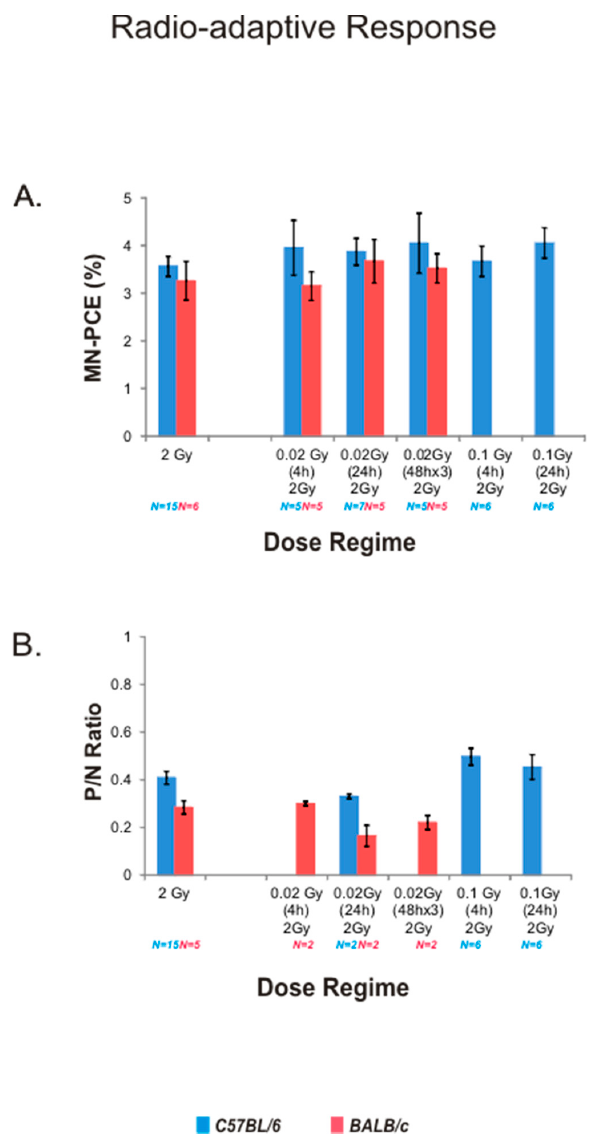
Figure 4. Radio-adaptive response analysis of MN-PCE frequencies and P / N Ratios in mouse bone marrow. Single or multiple LDR priming doses were delivered to C57BL/6 mice (blue columns) and BALB/c mice (red columns) prior to a 2 Gy challenge dose. Mice were euthanized 24 h post challenge dose and MN-PCE frequencies ( A ) and P / N ratios ( B ) were measured. Treatment groups receiving a 2 Gy radiation dose alone served as control groups (reproduced from Figure 2). N = number of animals sampled per treatment group. Data points represent the mean value of pooled samples; error bars indicate standard error.